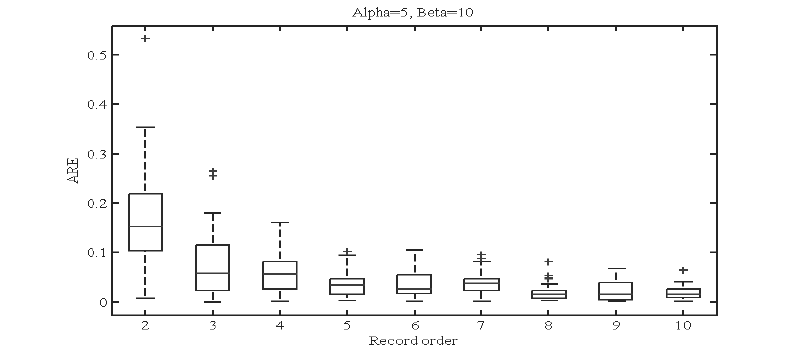
Figure 6 – Boxplot for ARE of ˆ (cid:68) .